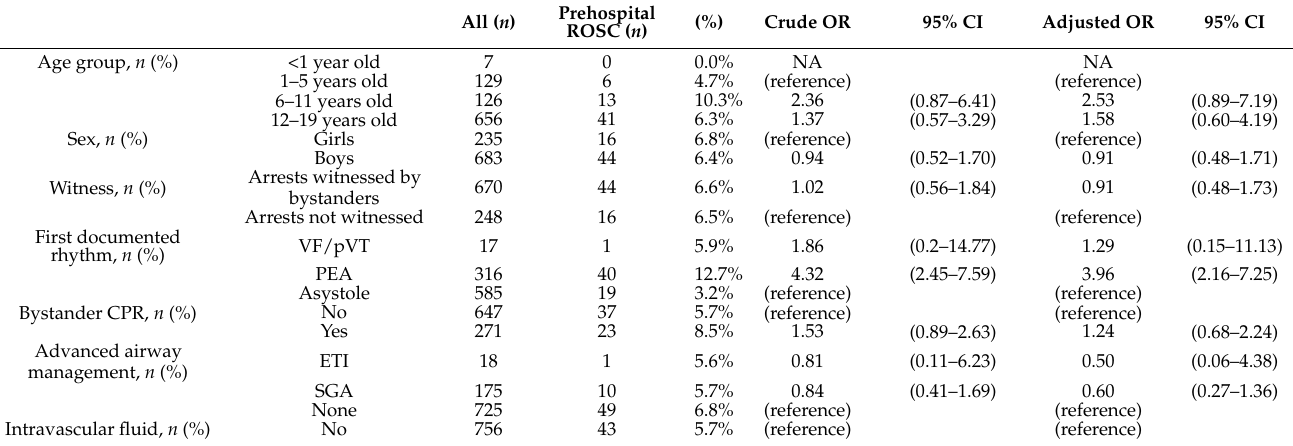
Table 4. Factors associated with prehospital return of spontaneous